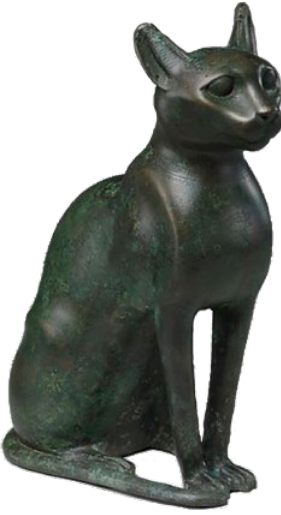
Figure 4. Bronze statue of the Goddess Bastet. Figure 5. Gold Pectoral (parts soldered by colloidal hard